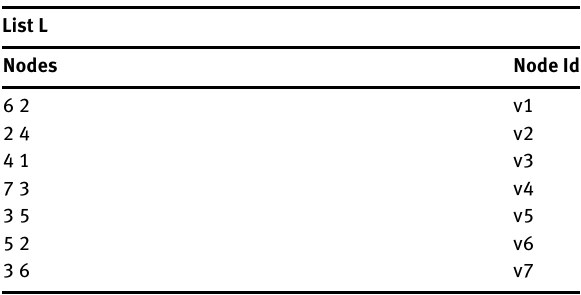
Table 3: Nodes and Node Id of Sample Data.